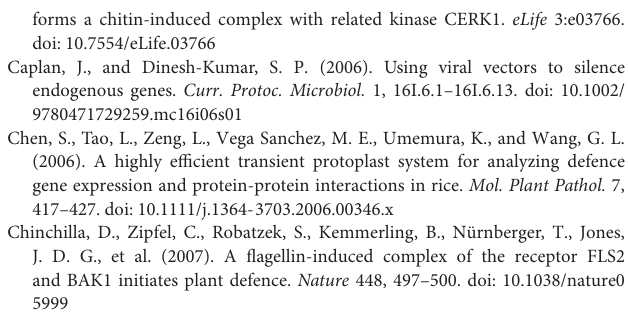
FIGURE S1 | The Phylogenetic tree of 61 Arabidopsis PUB proteins and 21 tomato homologous proteins of AtPUB12 and 13. The unrooted phylogenetic tree was generated by the neighbor-joining method using the MEGA6 program with 1000 bootstrap trials (Saitou and Nei, 1987; Tamura et al., 2013). FIGURE S2 | Purified tomato GST-SlPUB13 and GST-NtCMPG1 proteins as shown by SDS-PAGE. The amount of 3 µ L of purified recombinant proteins of GST-tagged SlPUB13 and NtCMPG1 were separated by 10% SDS PAGE and stained with Coomassie Brilliant Blue. The numbers on the left denote the molecular mass of marker proteins in kD. The red arrow denotes the band of purified recombinant proteins. FIGURE S3 | SlPUB13 showed no specificity toward the tomato ubiquitin E2 enzymes SlUBC16 and SlUBC17. Tomato E2 UBC16 and UBC17 displayed auto-ubiquitin-conjugation activity in the absence of an E3 ligase (lane 2 and 5). The presence of GST-SlPUB13 or GST enhanced the conjugation activity of poly-ubiquitin and GST-SlUBC16- or 17-(Ub)n but did not alter the pattern of the conjugates formed (lane 1, 4, 7, and 8). Tomato E2 UBC12 of group III was included as control. GST-SlPUB13-(Ub)n conjugates were detected only in the reaction in which 6HIS-UBC12 was presented (lane 10). The numbers at the top mark the lanes/reactions. In the absence of tomato UBC16 and 17, no ubiquitin conjugation was observed (lane 3, 6, and 9). The numbers on the right denote the molecular mass of marker proteins in kD. FIGURE S4 | Group III E2s but not non-group III E2s interact with tomato SlPUB13 in yeast two-hybrid. (A) Group III E2s UBC9, 39 and 40 were randomly selected for the test and were found to interact with the U-box domain of tomato SlPUB13 in yeast two-hybrid. Empty vectors and non-group III E2s UBC13, 27, 36, 16, and 17 were used as control. (B) Expression of the bait and prey proteins for the yeast two-hybrid assay was examined by immunoblotting. FIGURE S5 | Determination of the effectiveness and specificity for silencing group III E2 genes in TRV- group III -infected N. benthamiana plants. The transcript level of group III E2 genes and non-group III E2 genes, NbUBC16 and NbUBC17 in non-silenced TRV control (TRV) and TRV- group III- infected N. benthamiana plants was examined by semi-quantitative PCR. NbEF1 α was used as an internal reference for determining the amount of cDNA template to be used. Numbers under the gel bands denote the percentage of reduction (%) in the expression of corresponding gene in TRV- group III -infected plants compared to that in non-silenced TRV control plants. TABLE S1 | List of primers used in this